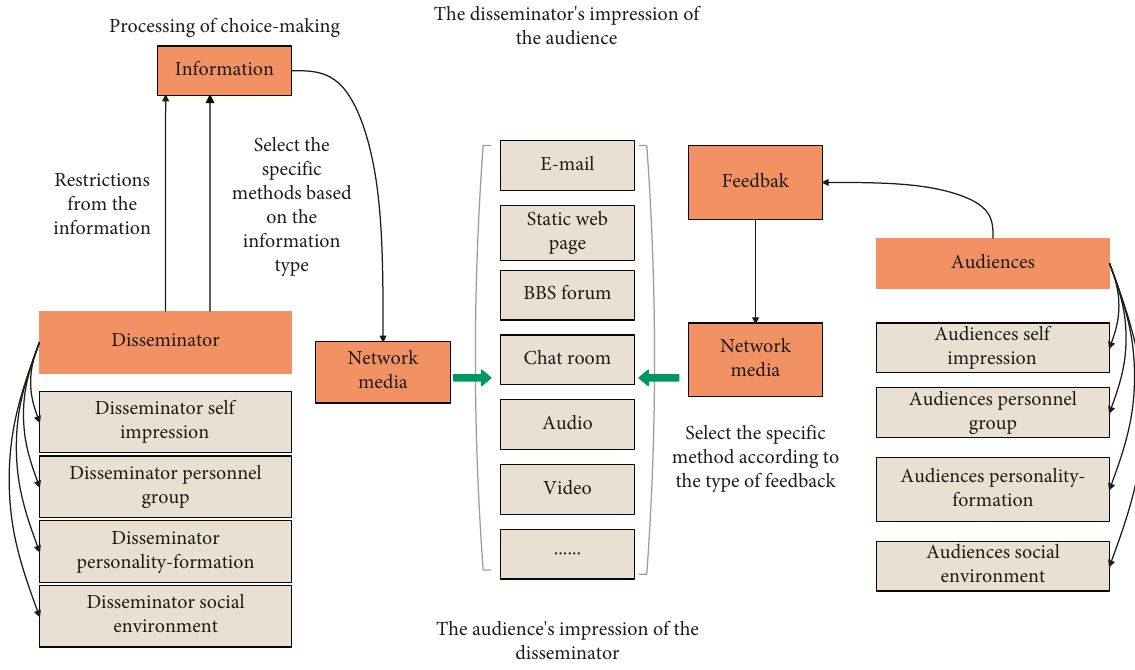
Figure 4: Network information dissemination mode.